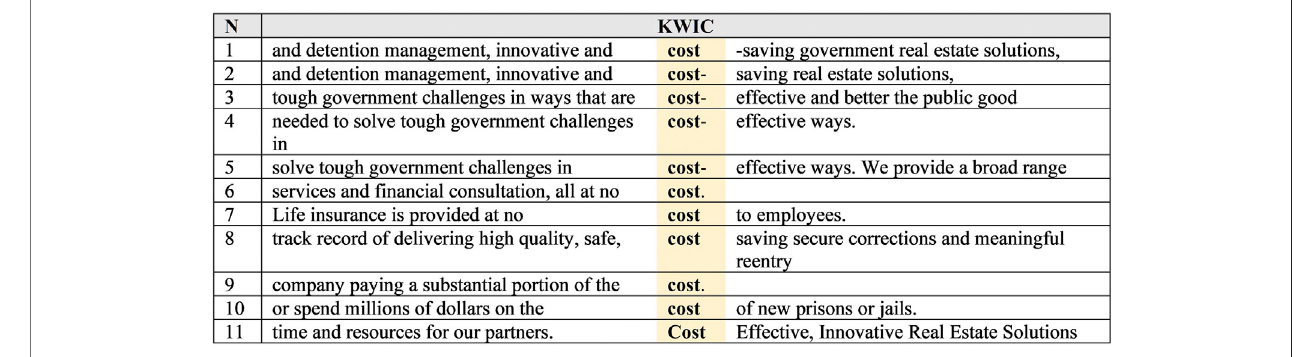
FIGURE 5 | CoreCivic corpus, “ cost ” concordance lines. > The following section proceeds to present the fi ndings for The GEO Group.